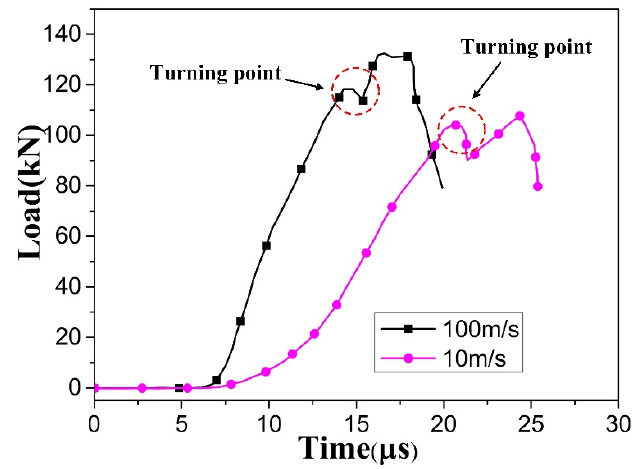
Figure 5. Figure 5. Load–time curves in the dynamic Brazilian disc test at different loading speeds from Ref. [24].